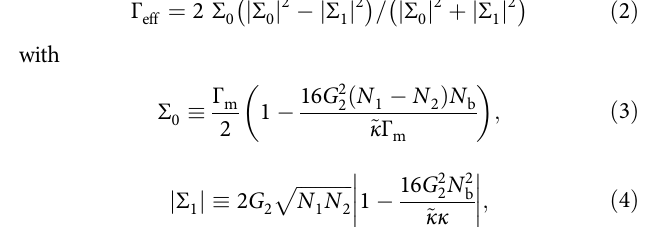
Fig. 4 BEC optomechanics: self-oscillation and mechanical induced BEC sidebands. PL spectra of the fundamental ( a ) and fi rst excited ( b ) polariton BEC mode with mechanically induced sidebands (red connected symbols). The solid thin black line is a fi t to Eq. (1) yielding χ ~ 0.65 (see text for details). The asterisk indicates a peak due to PL from a neighbor trap, which was added ad hoc in the